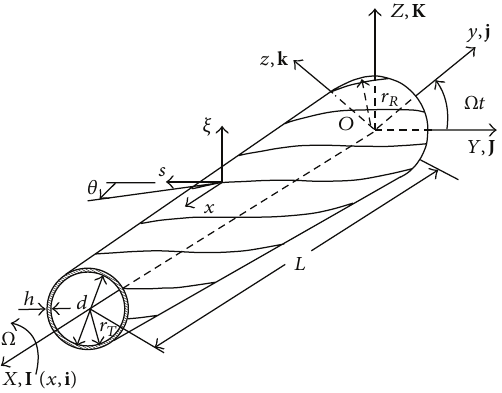
Figure 1: Coordinate systems and geometry of thin-walled rotating